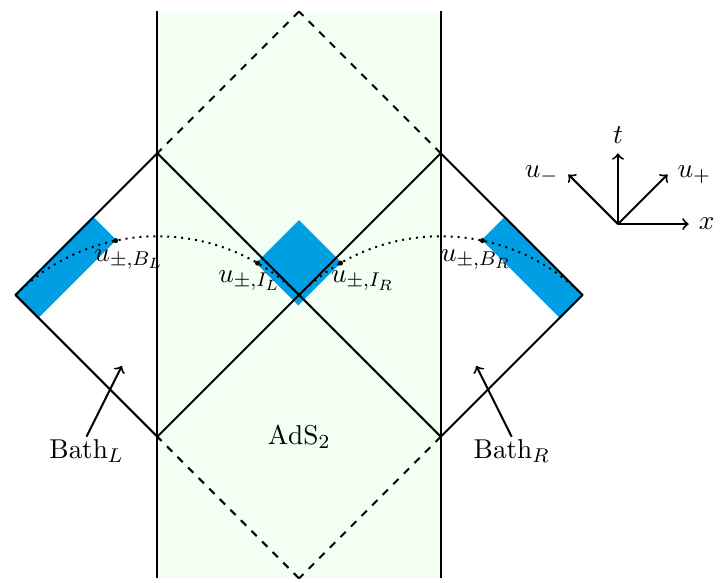
Figure 9 . We have two AdS black holes coupled to baths. If we consider the entanglement wedge of the bath region shown in the (cid:12)gure, it includes an island in the bulk at late time. that is one can reconstruct an operator in the island using operators in the bath region [ a ; b ] and its microscopic modular Hamiltonian K 2 2